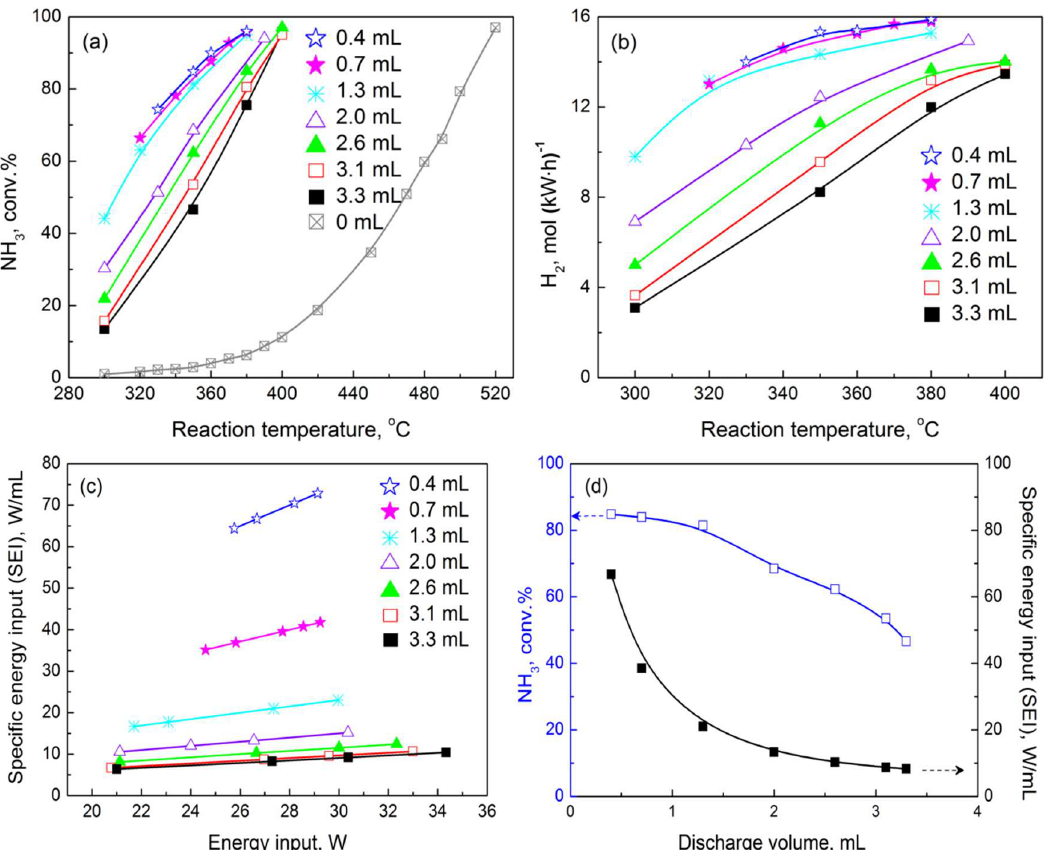
Figure 6. Influence of discharge volume on ( a ) ammonia conversion, ( b ) energy efficiency of H 2 formation, ( c ) specific energy input (SEI) and ( d ) relationship of ammonia conversion with SEI (NH 3 feed rate 40 mL/min, discharge gap 3 mm, discharge frequency 12 kHz, and the packing amount and packing volume of catalyst in the reactor was fixed at about 3 g and 3.1 mL, respectively. Changing the discharge volume “V” from 3.3 to 0.4 mL enabled the catalyst to be partly packed in the discharge area, as shown in Scheme 1, and the catalyst was fully packed in the field of plasma only when the discharge volume was over 3.1 mL; The reaction temperature originated from electric heat released by discharge, and was determined using an IR camera and thermocouple tightly attached to the outer wall of the reactor [12]).